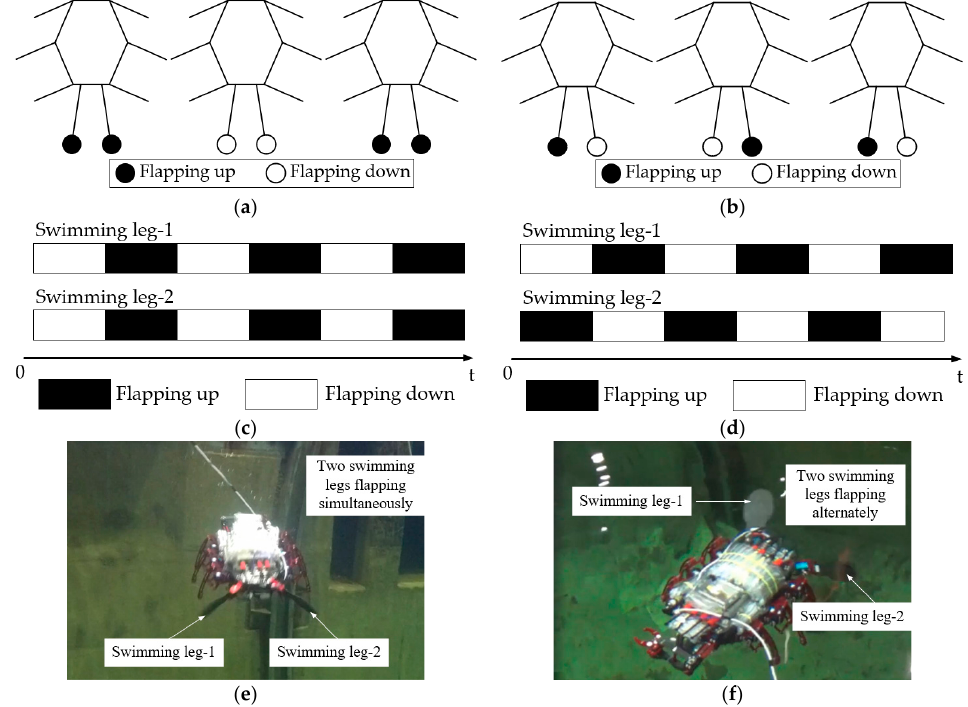
Figure 13. The swimming gaits and experiment in the pool. ( a , c ) are the stage sequences of swimming gait 1. ( b , d ) are the stage sequences of swimming gait 2. ( e ) is the experiment where two swimming legs flap simultaneously. ( f ) is the experiment where two swimming legs flap alternately. The